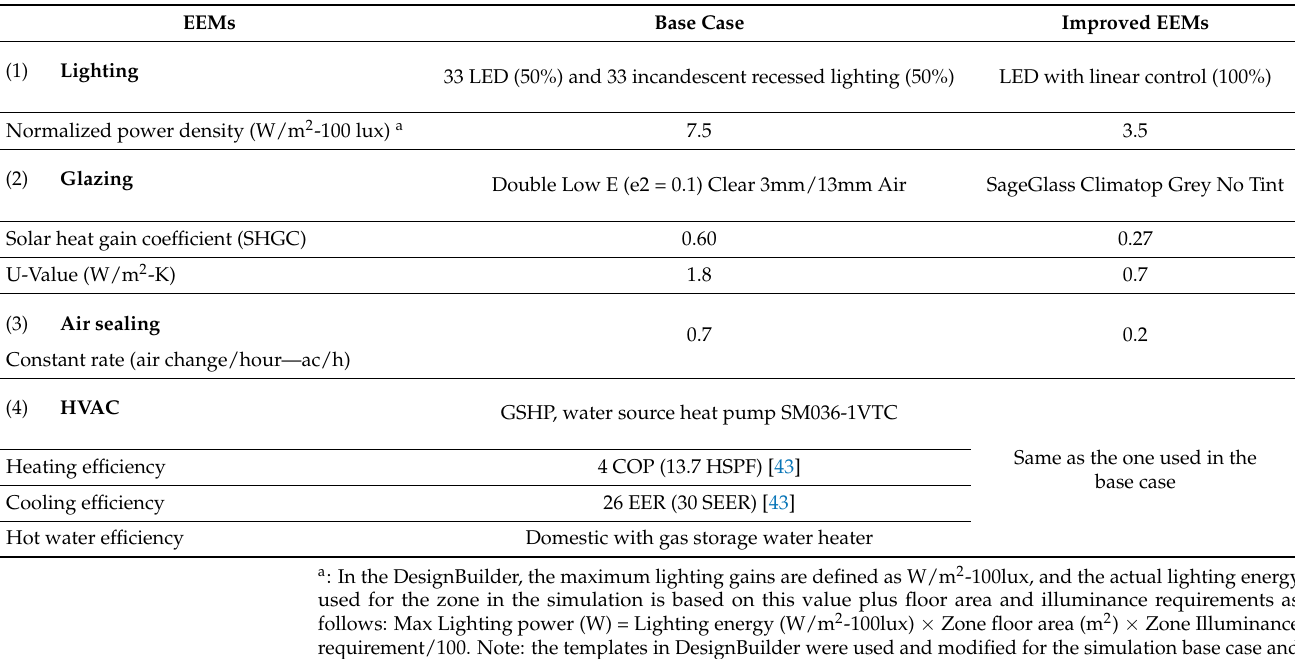
Table 7. Specification for building C and the improved EEMs used in the